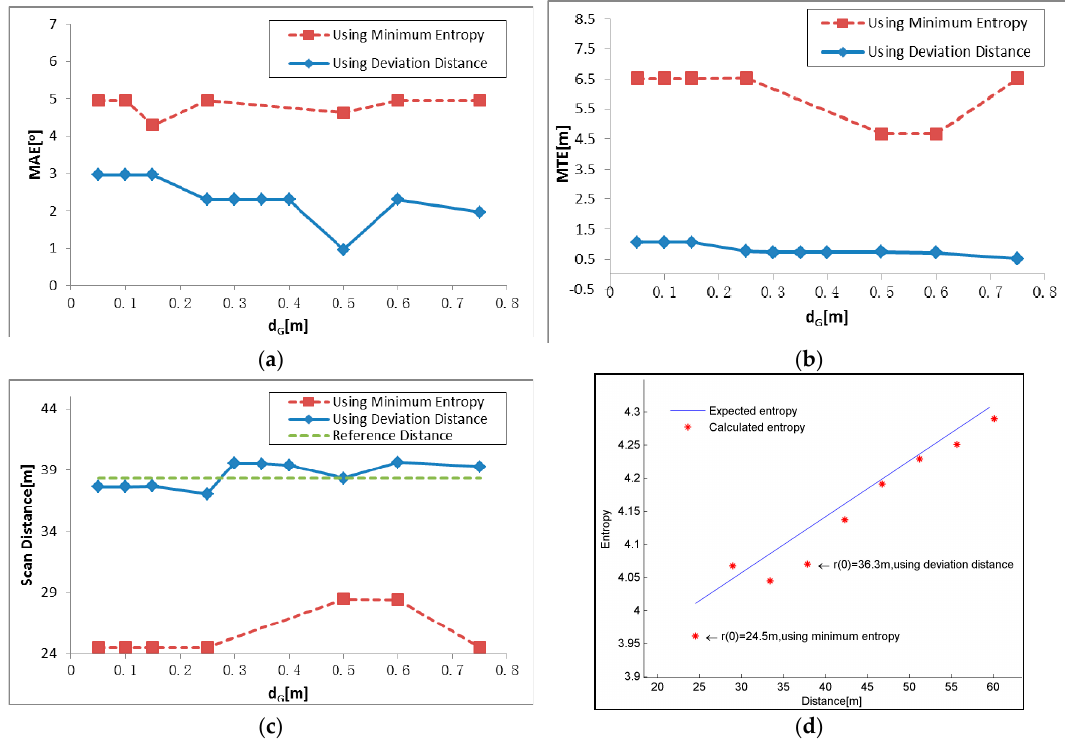
Figure 16. Comparison of two initial value selection criteria, using minimum entropy and using deviation distance: ( a ) MAE; ( b ) MTE; and ( c ) Scan distance; and ( d ) the selecting process in detail. Although the distance 24.5 m corresponds to the smallest entropy, 36.3 m, which is much closer to reference distance of 38.302 m, is selected based on deviation distance.